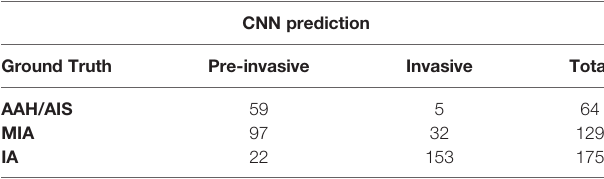
TABLE 4 | Confusion matrix of the CNN model for invasiveness